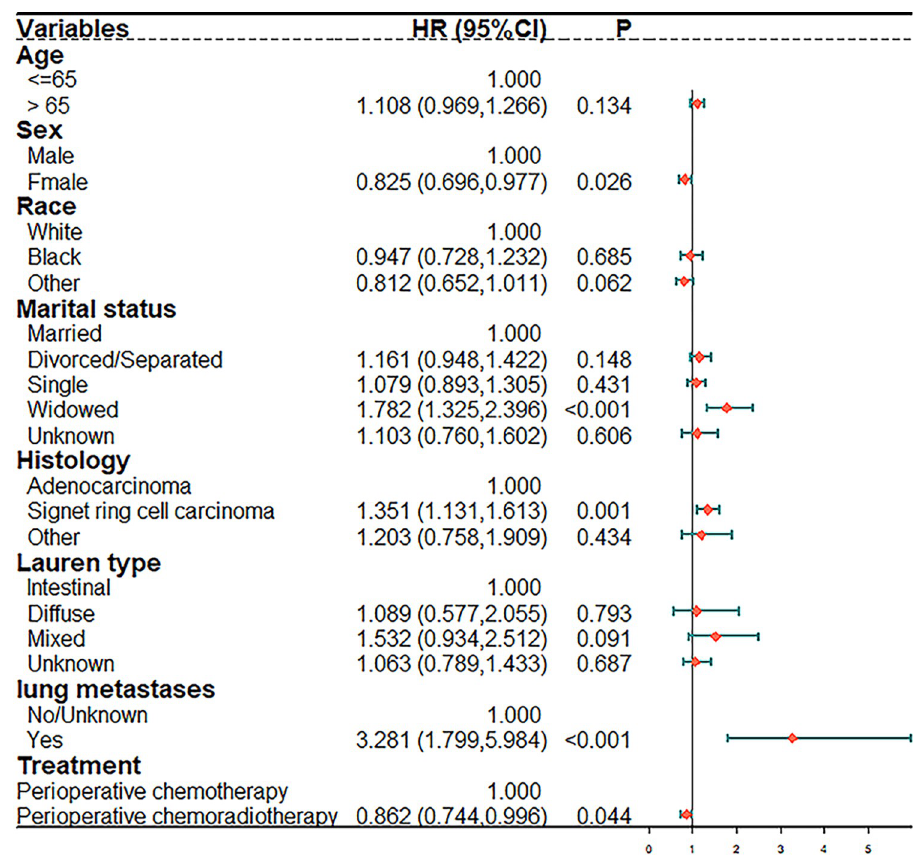
Fig 2. Multivariable cox regression analysis of the clinical features in the overall population. Forest plot demonstrating gastric cancer with advanced stage hazard ratios.